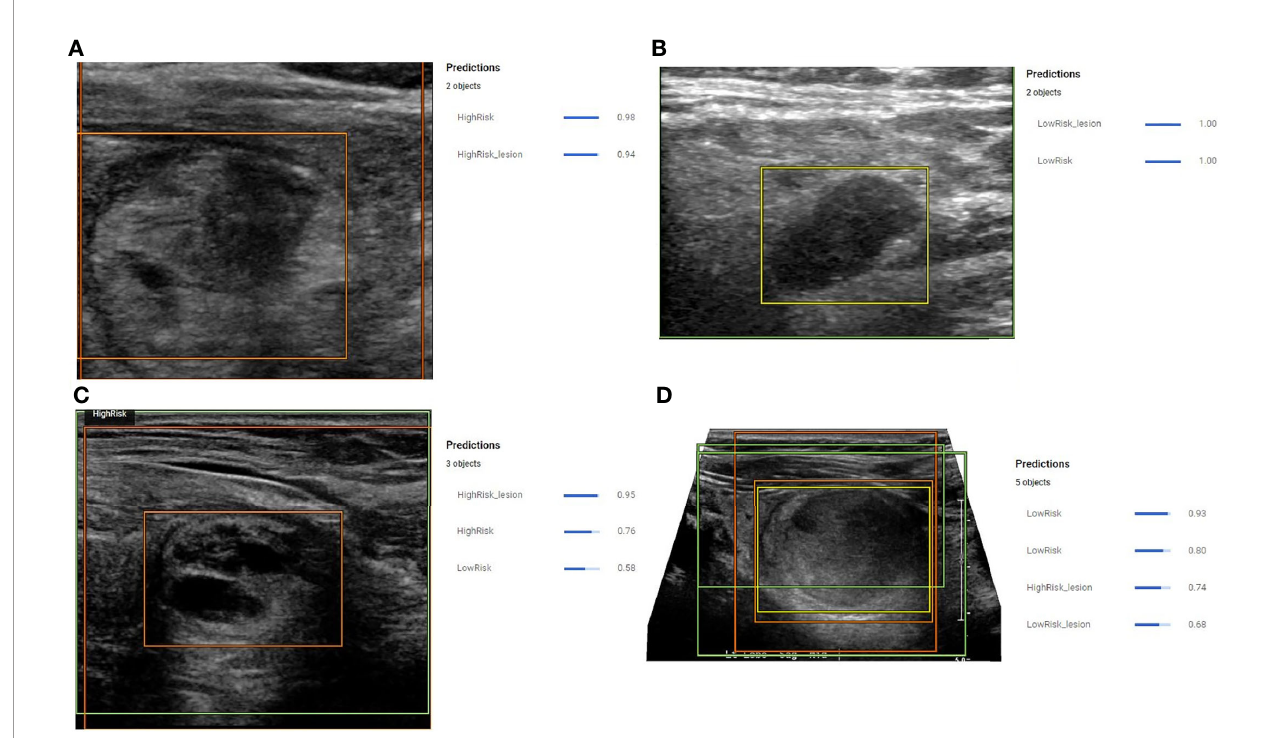
FIGURE 3 | (A) Example prediction from the Object Detection Model that correctly detected a nodule and correctly assigned a high-risk label with 98% certainty. The position of the high-risk nodule was marked by the orange color bounding box drawn by the model. (B) Example prediction from the Object Detection Model that correctly detected the nodule and correctly designated the lesion as low risk with 100% con fi dence. The position of the low-risk nodule was marked by the yellow bounding box drawn by the model. (C) Example prediction from the Object Detection Model that detected a high-risk lesion, a high-risk area, and a low-risk area with con fi dence scores of 0.96, 0.76, and 0.56, respectively. The position of the high-risk nodule was marked with the orange bounding box drawn by the model. (D) Example prediction from the Object Detection Model that detected the nodule but assigned both high-risk and low-risk labels. The model provided a con fi dence score of 0.74 for the nodule to be high risk and a con fi dence score of 0.68 for the nodule to be low risk. The model also indicated two low risk areas with a con fi dence score of 0.93 and